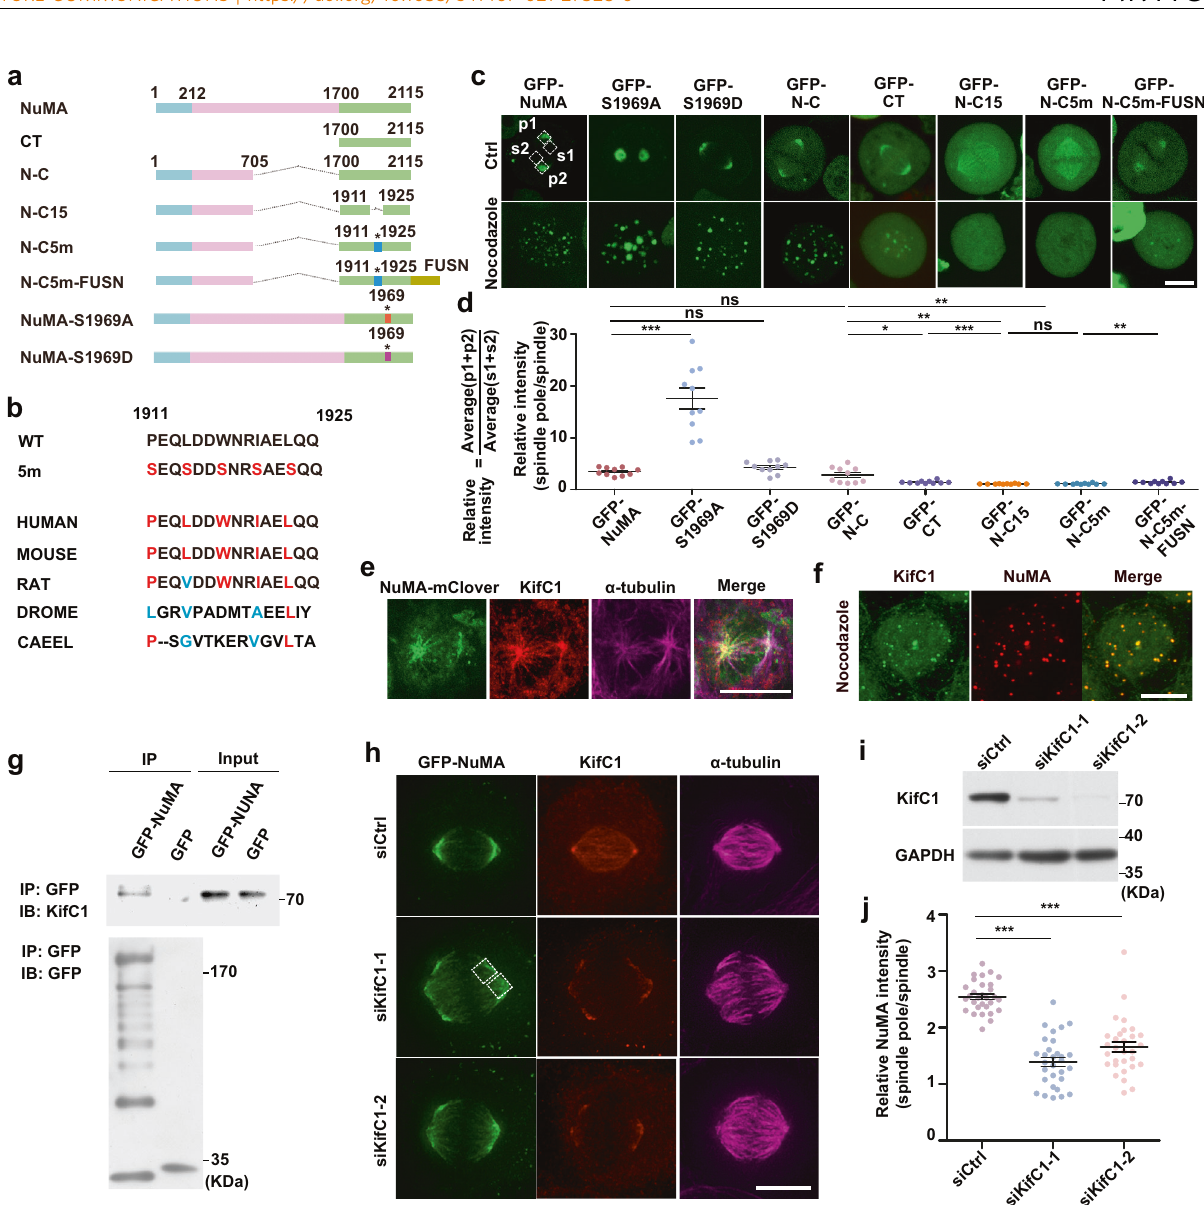
Fig. 5 Phase separation and KifC1 facilitate NuMA to concentrate on spindle poles. a Schematic drawing of truncated and mutated NuMA constructs. Asterisks indicate the mutated sites. b Mutagenesis of fi ve hydrophobic residues in N-C (black) to serine residues (red) in N-C5m. Multiple sequence alignment for the fi ve hydrophobic amino acids was performed using Uniprot. Red amino acids were conserved and hydrophobic, and blue amino acids were not conserved but hydrophobic. c Live cell images of NuMA- or mutant-expressing HeLa cells. Four white dotted boxes of 3×3 μ m denote areas to measure fl uorescence intensity. P1, P2, S1, S2: the mean fl uorescence intensity on drawing areas. d Schematic drawing and quanti fi cation of the relative fl uorescence intensity of NuMA mutants on spindle poles in c (mean±SEM, n = 10 cells per sample). Unpaired two-tailed t test: P <0.0001 for NuMA/S1969A, P = 0.0824 for NuMA/S1969D, P = 0.2263 for NuMA/N-C, P = 0.0108 for N-C/CT, P = 0.0009 for CT/N-C15, P = 0.5996 for N-C15/N-C5m, P = 0.0020 for N-C/N-C15, P = 0.0022 for N-C/N-C5m, P = 0.0065 for N-C5m/N-C5m-FUSN. e Immuno fl uorescence images of the assembling spindle in NuMA-mACF cells stained with anti-KifC1 and α -tubulin antibodies. f Immuno fl uorescence images of mitotic HeLa cells treated with nocodazole and stained with anti-NuMA and KifC1 antibodies. g Immunoprecipitation assay showing that NuMA interacts with KifC1. HEK293T cells were transfected with GFP, GFP-NuMA, arrested in mitosis with nocodazole and processed for IP assay with GFP-Trap beads. h Immuno fl uorescence images of mitotic spindles in HeLa cells stably expressing GFP-NuMA with control or KifC1 siRNA, followed by immunostaining with anti-KifC1 and α -tubulin antibodies. The DNA was stained with DAPI. Two white dotted boxes of 3×3 μ m denote areas to measure fl uorescence intensity. i Immunoblotting for KifC1 and GAPDH expression in cell lysates with control and KifC1 siRNA knockdown. j Quanti fi cation of the relative NuMA fl uorescence intensity on spindle poles in h (mean±SEM, n = 30 cells per sample). The relative intensity was de fi ned according to the method in d . Unpaired two-tailed t test: P <0.0001 for siCtrl/siKifC1-1 and siCtrl/siKifC1-2. * P <0.05, ** P <0.01, and *** P <0.001, ns, not signi fi cant. Scale bars, 10 μ